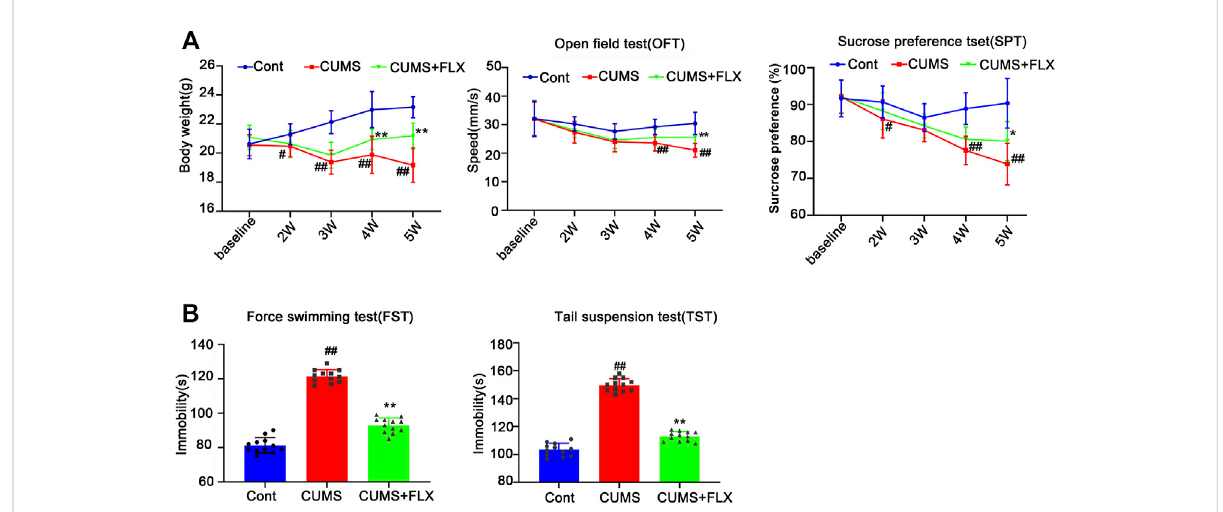
FIGURE 5 Fluoxetine (FLX) treatment improves CUMS-mediated depressive-like behaviors in mice. Mice were treated with CUMS for 5 weeks, and the body weight, open fi eld test and sucrose preference test were performed before and after CUMS treatment for 2, 3, 4 and 5 weeks (A) The line chart graphicallyshowsthatbodyweight,open fi eldtestandsucrosepreferencetestwerechangedatdifferentweeks.Thedataareexpressedasthemean ± SD ( n = 12 per group). #p < 0.05 , ##p < 0.01, vs. Cont. group; **p < 0.01 vs. CUMS. Statistical analysis was carried out with two-way ANOVA followedbya posthocTukeytest . (B) FLXtreatmentdecreasedtheimmobilitytimeofCUMSmiceintheforceswimmingtestandtailsuspensiontest. The force swimming test and tail suspension test were performed at week 5 after CUMS treatment. The results are expressed as the mean ± SD ( n